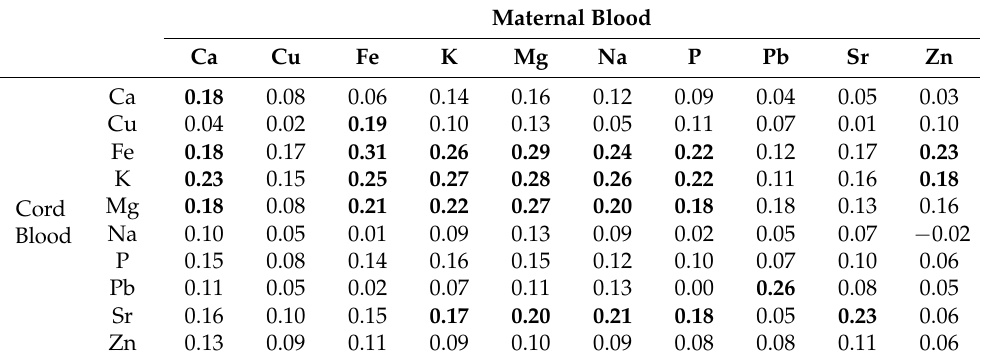
Table 6. Spearman’s rank correlation cofactors between elements in the maternal and cord